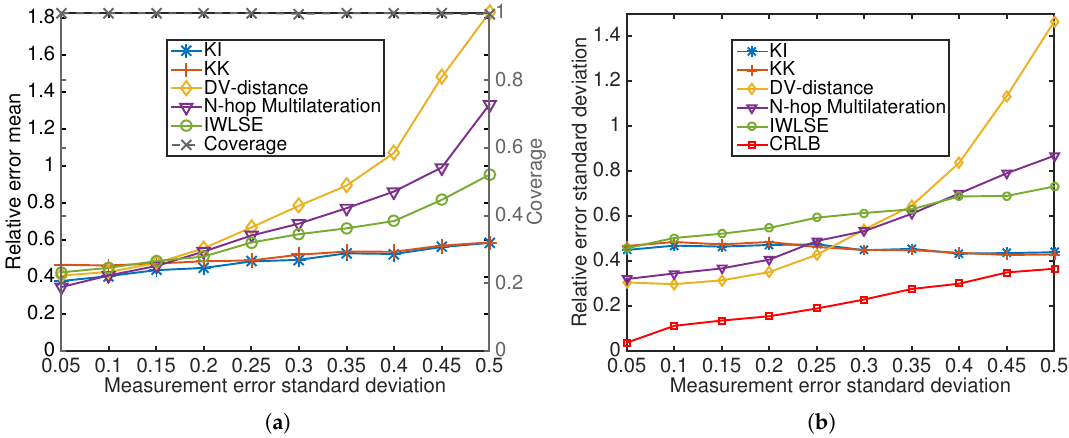
Figure 13. ( a ) Average estimation error and coverage, ( b ) SD w.r.t. different measurement error